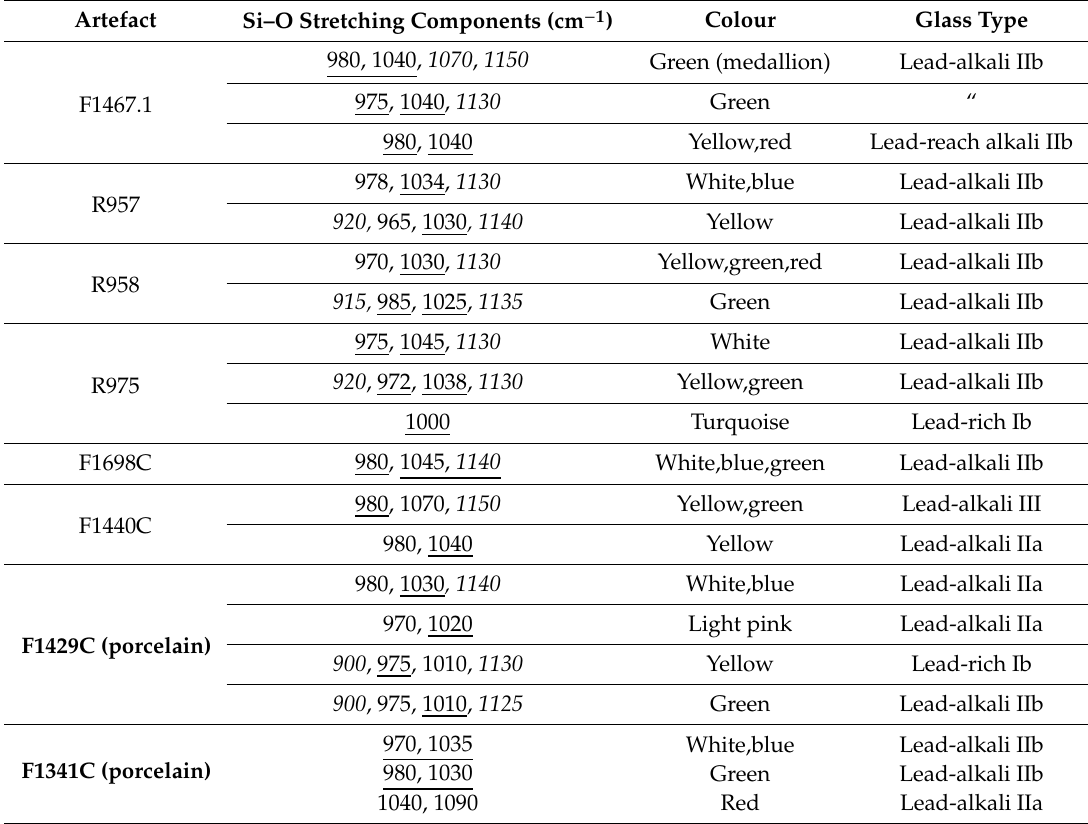
Table 5. SiO 4 stretching components of the painted enamels (strongest; shoulder ).